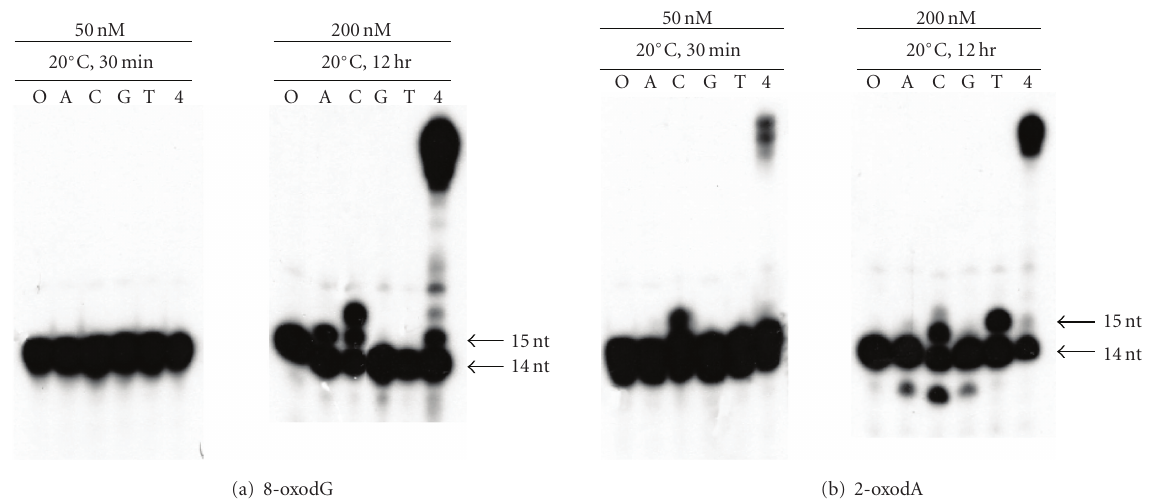
Figure 3: Primer extension assay for Pol IV to bypass 8-oxodG and 2-oxodA in the template oligonucleotide. Primer 3 was labeled at the 5 (cid:4) - terminal by polynucleotide kinase and annealed with appropriate template oligonucleotides. Primer 3/templates (50fmol) in a 10- μ l reaction mixture were incubated at 20 ◦ C with purified Pol IV at 50 nM for 30 min (left) and at 200nM for 12 hr (right), followed by polyacrylamide gel electrophoresis. (a) 8-oxodG (primer 3/template 4), (b) 2-oxodA (primer 3/template 2).